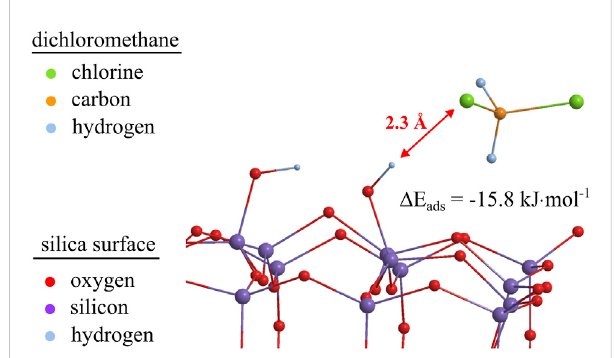
FIGURE 10 Optimized geometry for dichloromethane adsorbed on silanol groups of a 32 Si-member silica cluster model at the B3LYP/6-31G (d, p) level of theory. For reasons of demonstrability, protons at the silica cluster ’ s boundaries are